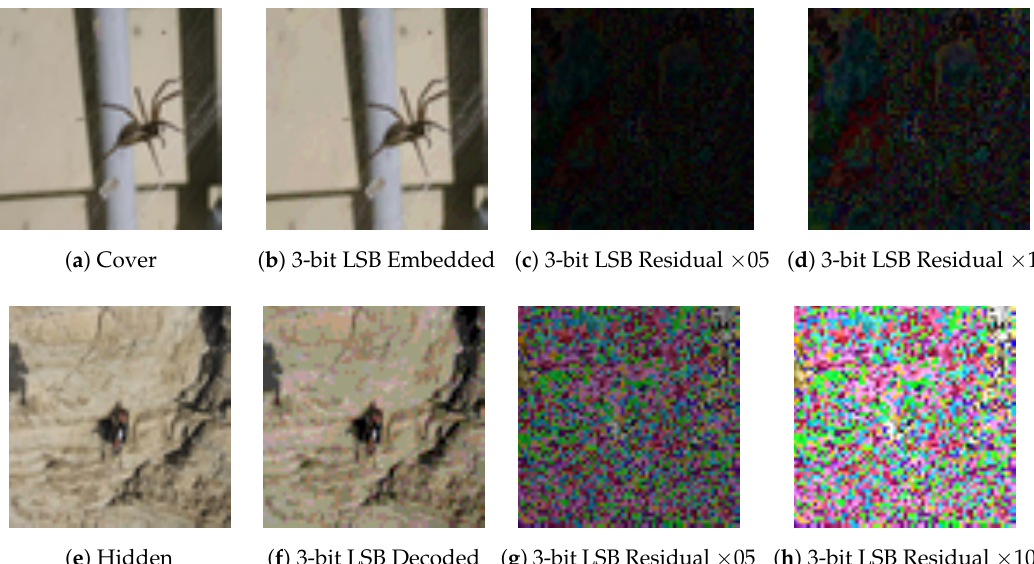
Figure 7. 3-bit LSB residual images “ × 05” and “ × 10” are the pixel-wise enhancement